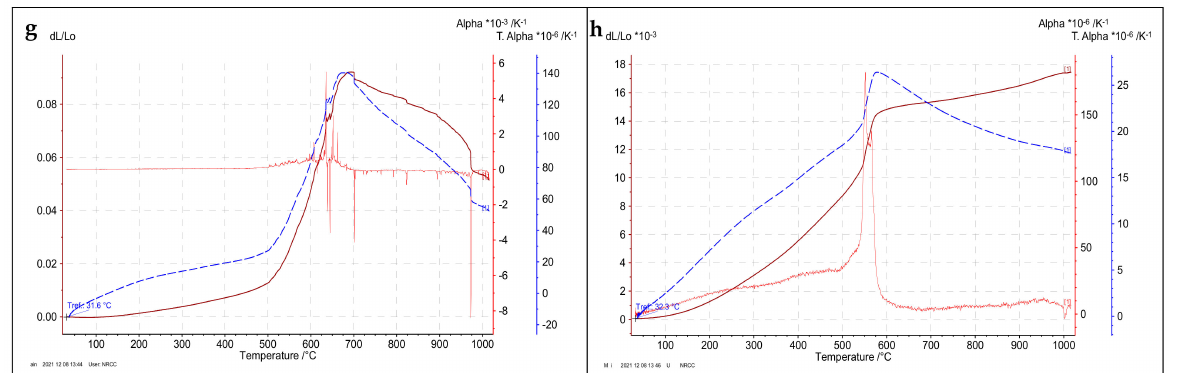
Figure 7. Linear thermal expansion (LTE) patterns showing the behavior of different granitic rocks under increasing temperatures: ( a ) gandonna; ( b ) pink granite; ( c ) buff granite I; ( d ) buff granite II; ( e ) fantazia; ( f ) red granite; ( g ) rosa granite; ( h ) qusseir brown.